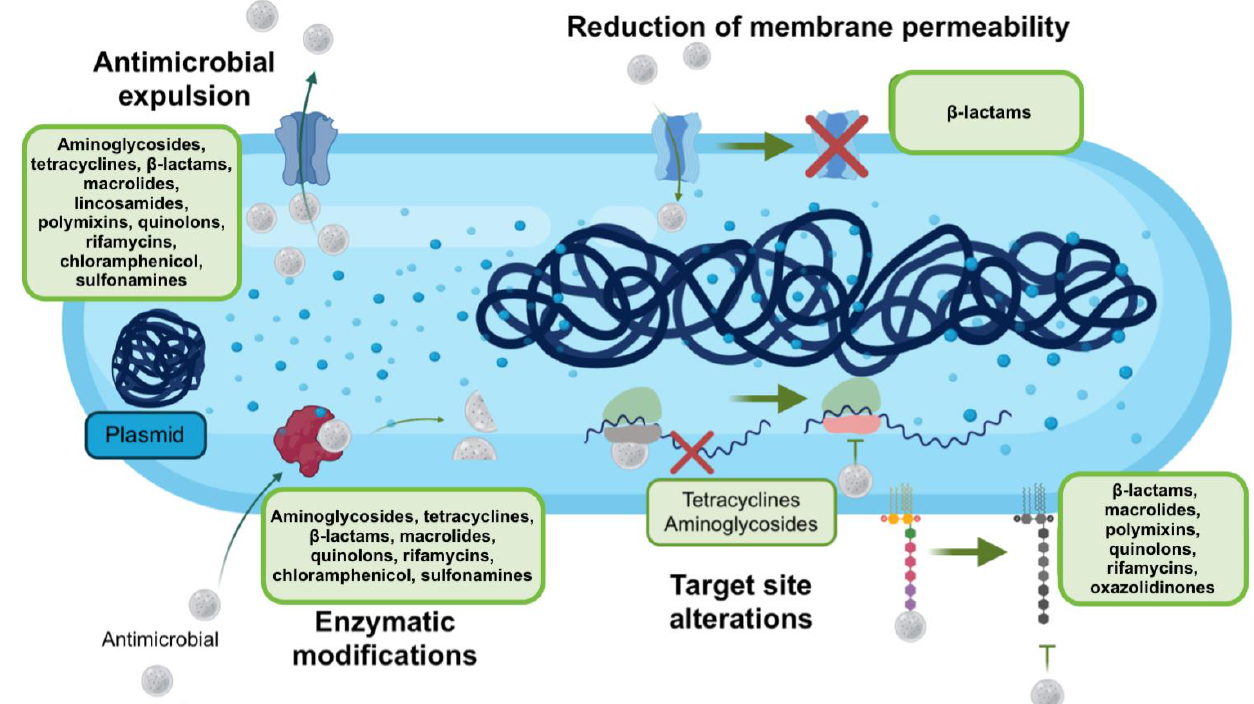
Figure 1. Mechanisms used by A. baumannii to evade the action of antimicrobials. A. baumannii use various mechanisms to prevent antimicrobials from causing damage, among which are the expulsion of these compounds, the decrease in permeability so that they cannot penetrate, as well as the modification of their target sites or the degradation of these compounds by enzymatic action. Taken and modified from [61]. Created with BioRender.com (accessed on 3 June